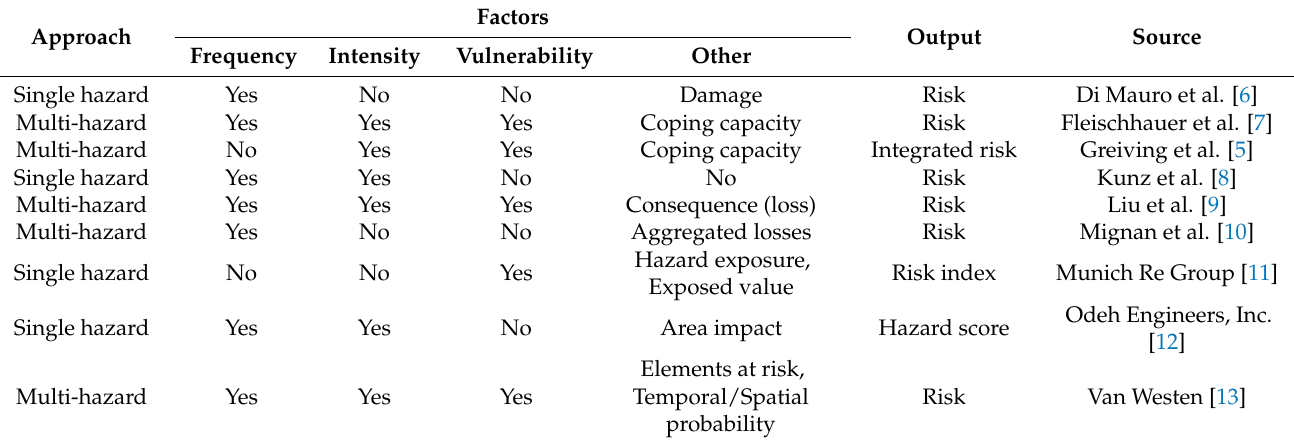
Table 1. Brief literature survey on factors used to calculate the risk of natural